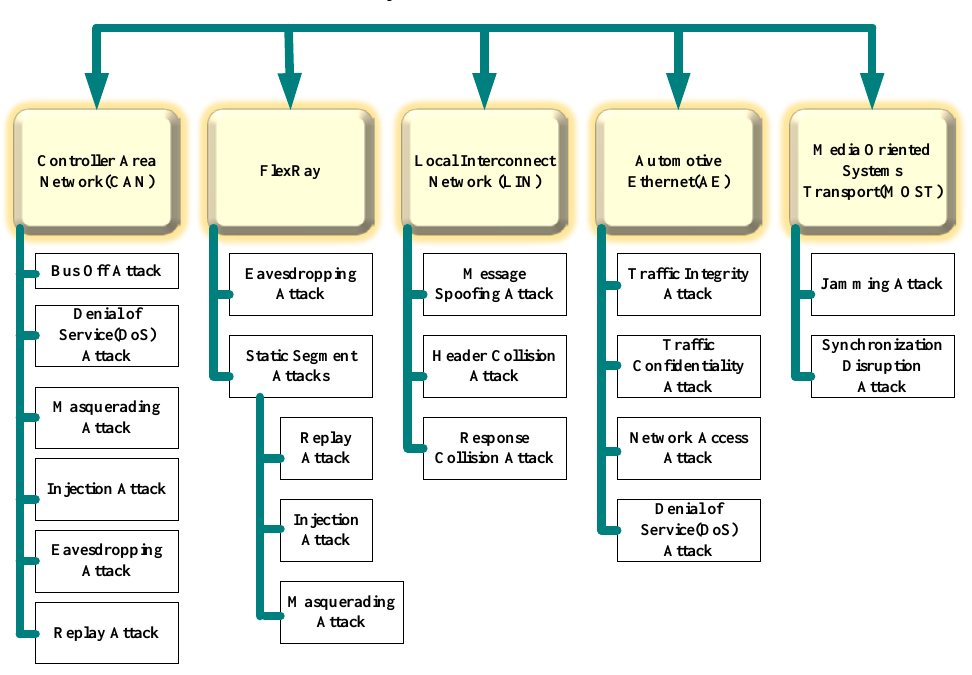
Figure 9. Classification of automotive protocols and possible security threats .